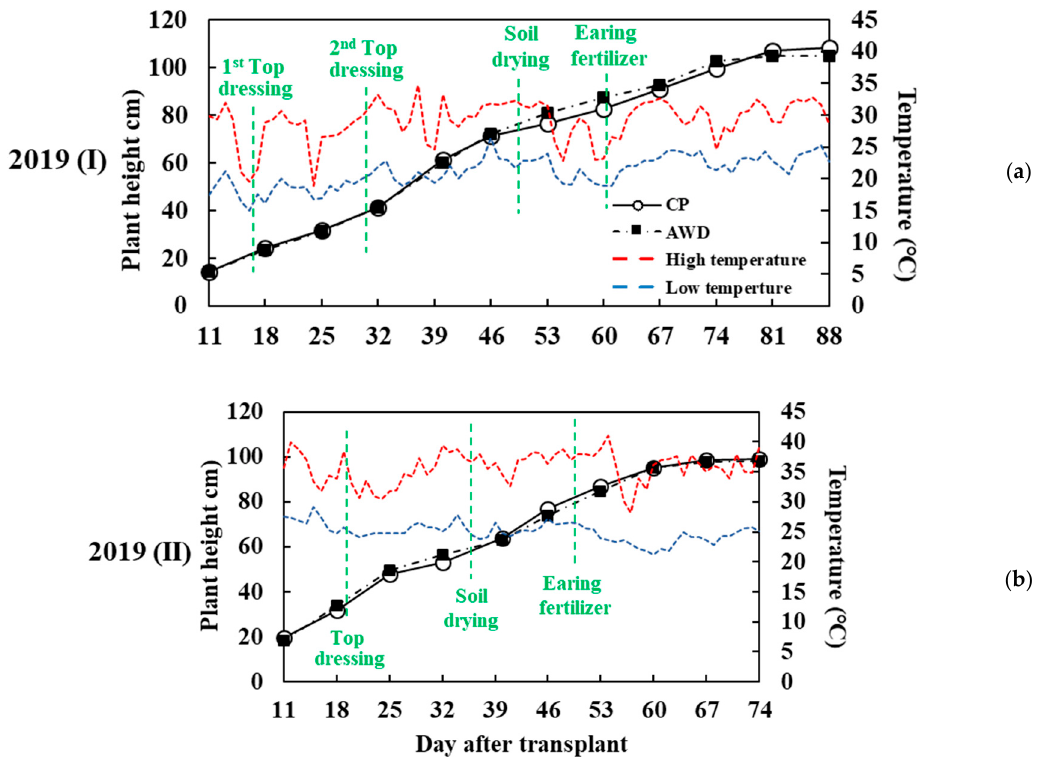
Figure 1 0 . ( a ) Field irrigation; ( b ) yield of TNG71 under different water treatments in the first and Figure 10. ( a ) Field irrigation; ( b ) yield of TNG71 under di ff erent water treatments in the first and second crop seasons. second crop seasons.